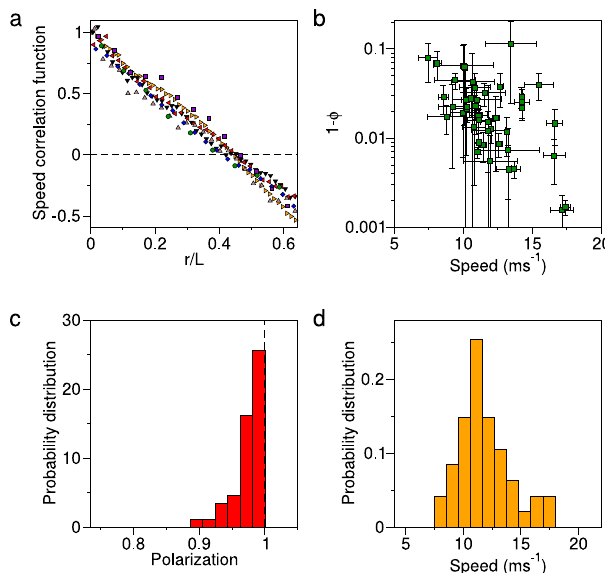
Fig. 2 Experimental evidence on starling fl ocks. a The equal-time space correlation function of the speed fl uctuations (for the de fi nition of the correlation function see the “ Methods ” section), plotted against the distance r between the birds rescaled by the fl ock ’ s size L , for some typical fl ocks (each colour corresponds to a different fl ock); the fact that all the curves collapse onto each other indicates that the spatial range of the speed correlation, namely the correlation length ξ sp , scales with L , i.e. that the system is scale-free (see also Fig. 3a, c). b Scatter plot displaying polarization vs. mean speed of each fl ock in all recorded events; as the (cid:1) (cid:1) (cid:1) (cid:1) , is quite close to 1 for all fl ocks, it is more = v polarization, Φ ¼ ð 1 = N Þ ∑ i v i i convenient to plot 1 − Φ in log scale. Data show that starling fl ocks are highly ordered systems, incompatible with the standard notion of near- criticality (green points correspond to medians over time, error bars to median absolute deviations). The probability distributions of polarization and mean speed are reported in panels c and d , showing that the typical mean group ’ s speed is 12 m s − 1 , with fl uctuations of about 2 m s − 1